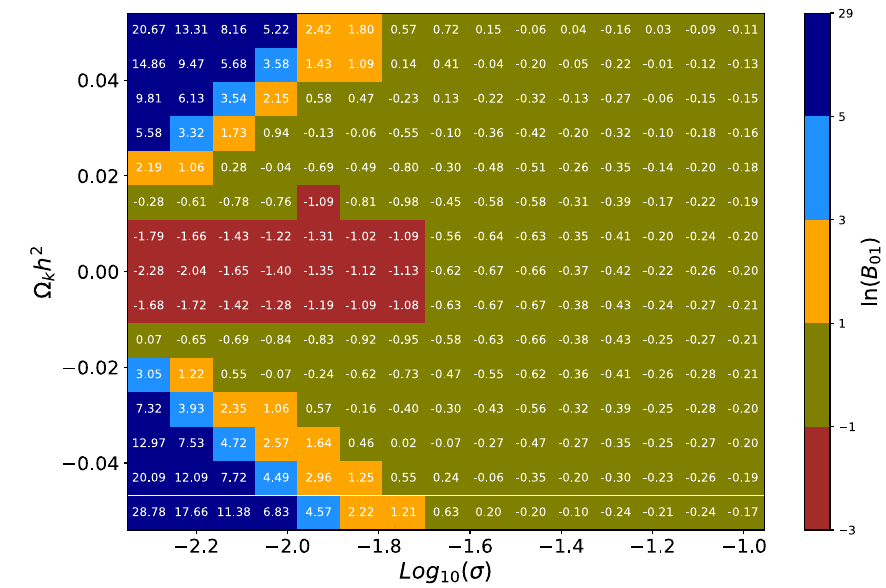
Fig. 4 The mean Bayes factor for the Λ CDM and N Λ CDM using the second sampling strategy. Different colors show